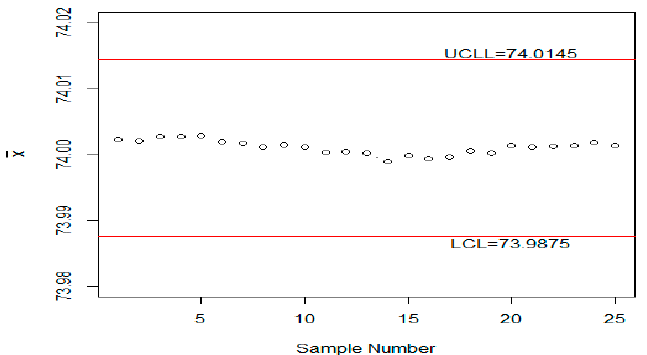
Figure 6. The X-bar chart under CS for the real data.